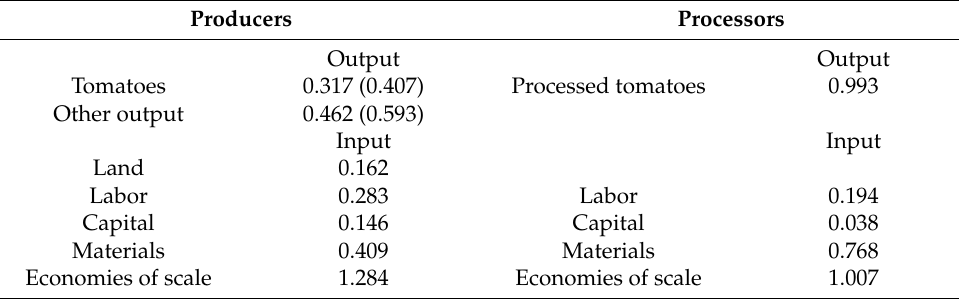
Table 2. Shadow shares. Source: authors’ estimates.